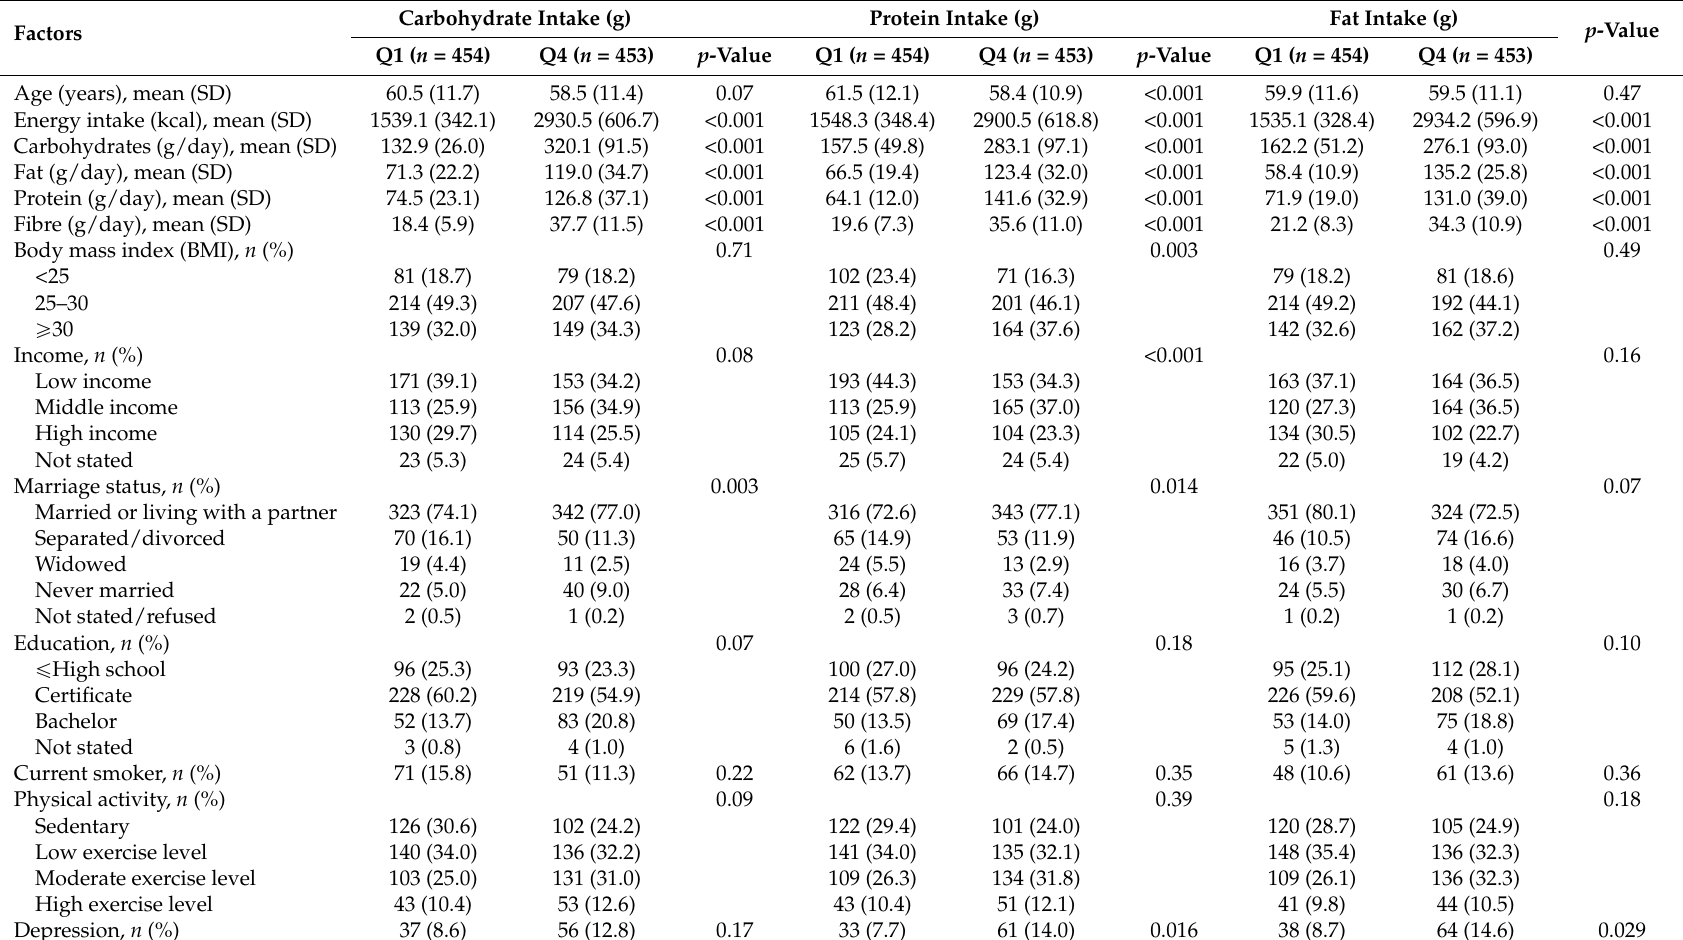
Table 1. Characteristics of subjects according to quartiles of each macronutrient intake ( n = 1815) 1